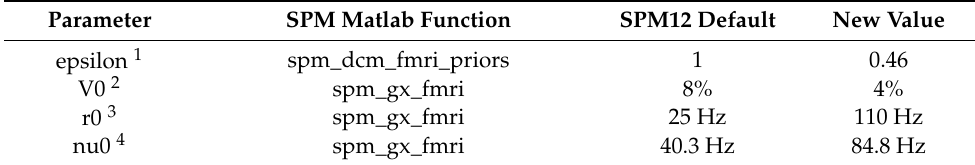
Table 1. Updated DCM